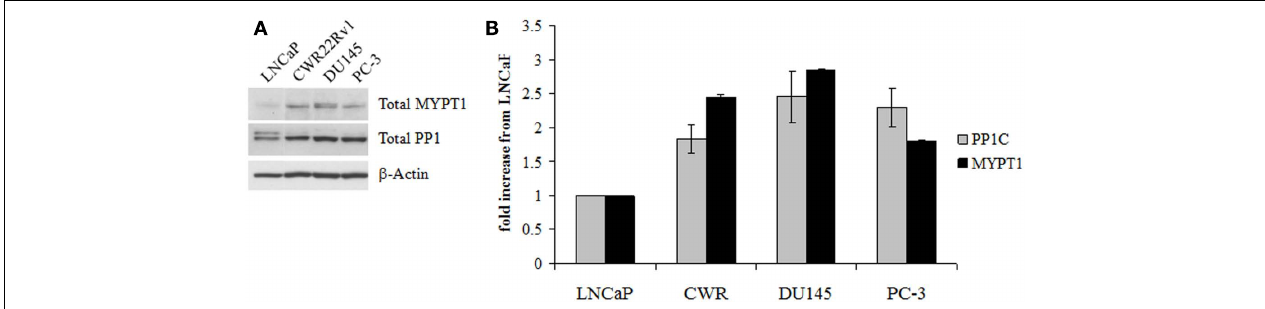
FIGURE 1 | Myosin light chain phosphatase protein content in untreated human prostate cell lines. (A) Western blot analysis of the two main constituent proteins of MLCP, MYTP1, and PP1C. (B) Densitometry of theWestern blot results normalized to LNCaP levels of protein. Error is represented as SEM, n =